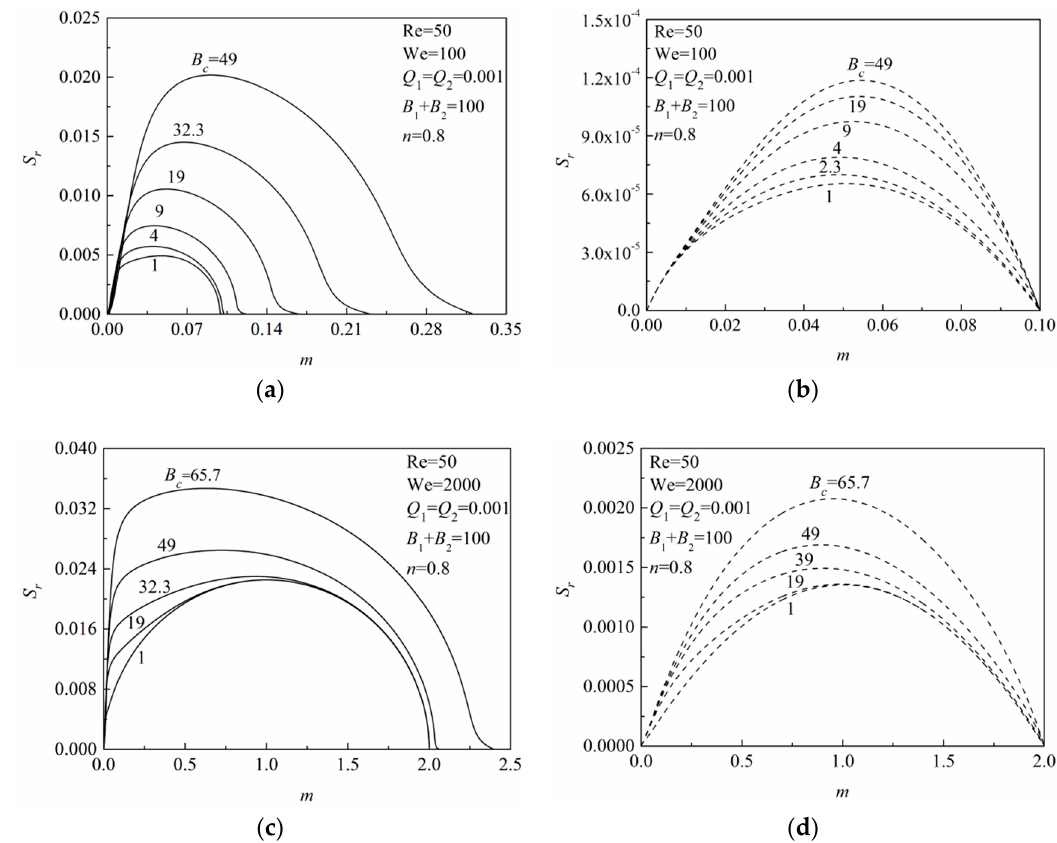
Figure 4. The dimensionless growth rate S r of disturbance waves as a function of the non-dimensional wave number m on different We numbers: ( a , b ) We = 100 and ( c , d ) We = 2000.The solid and dashed lines represent para-sinuous mode and para-varicose mode respectively.